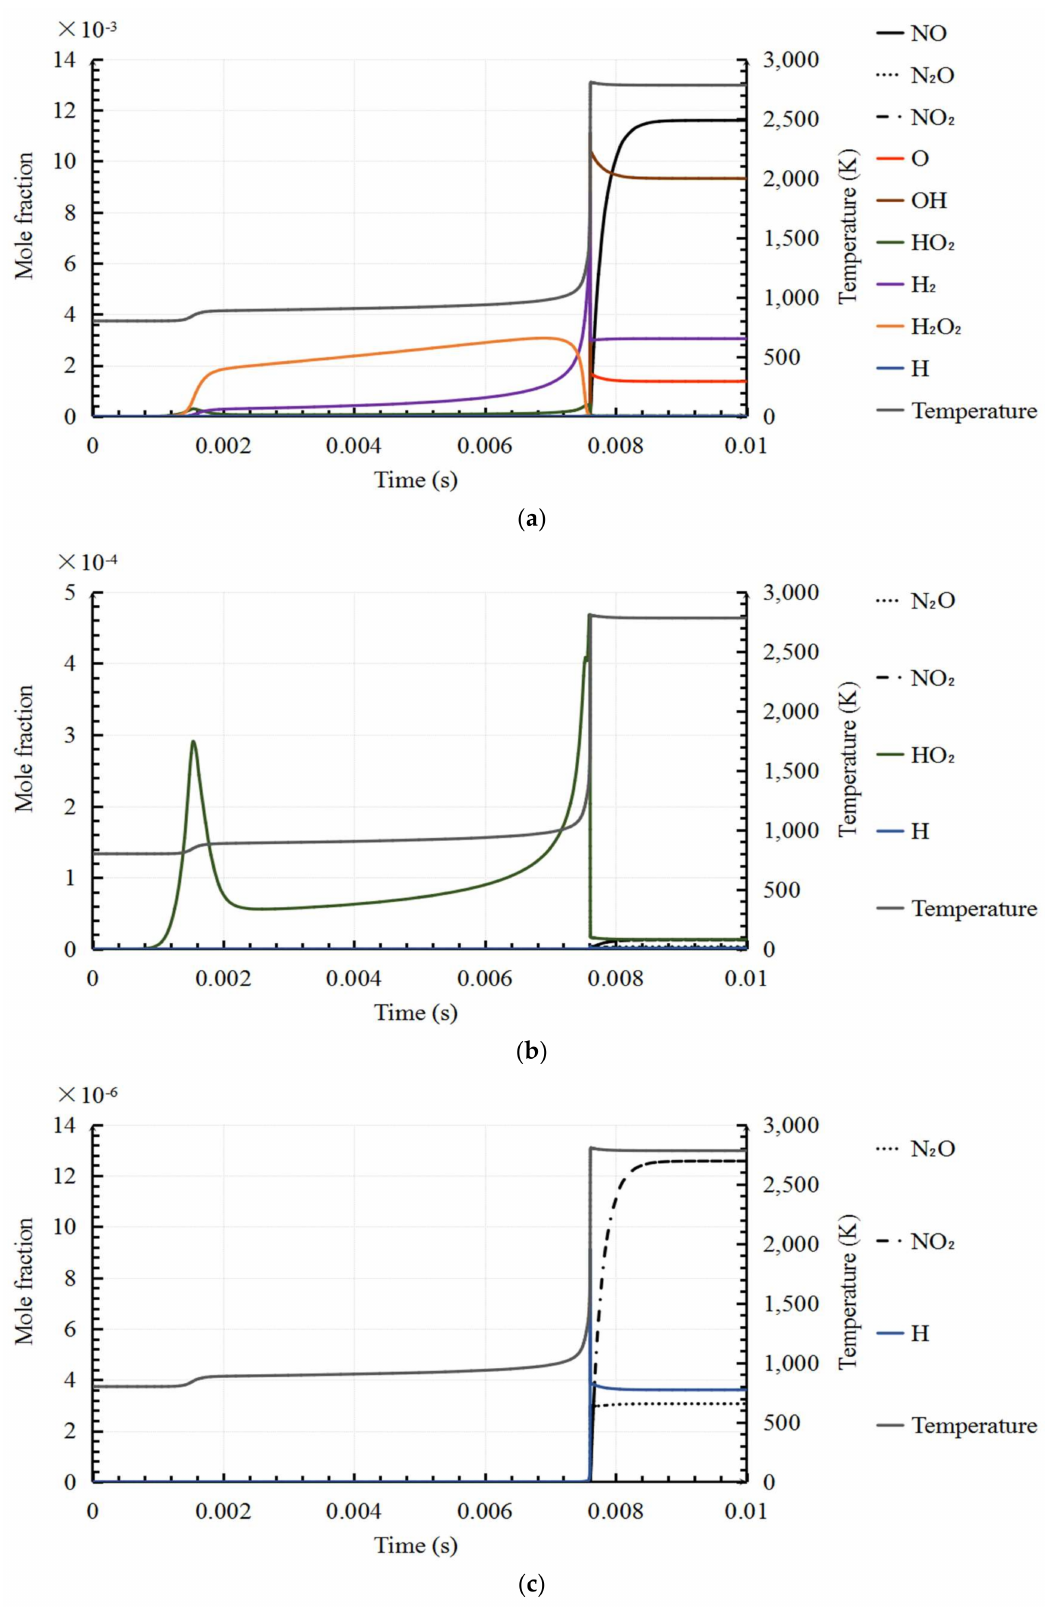
Figure 1. The iterative process of the intermediate products, NO x and temperature ( λ = 1, WOMR = 0). ( a ) Global comparison; ( b ) Detail comparison 1; ( c ) Detail comparison